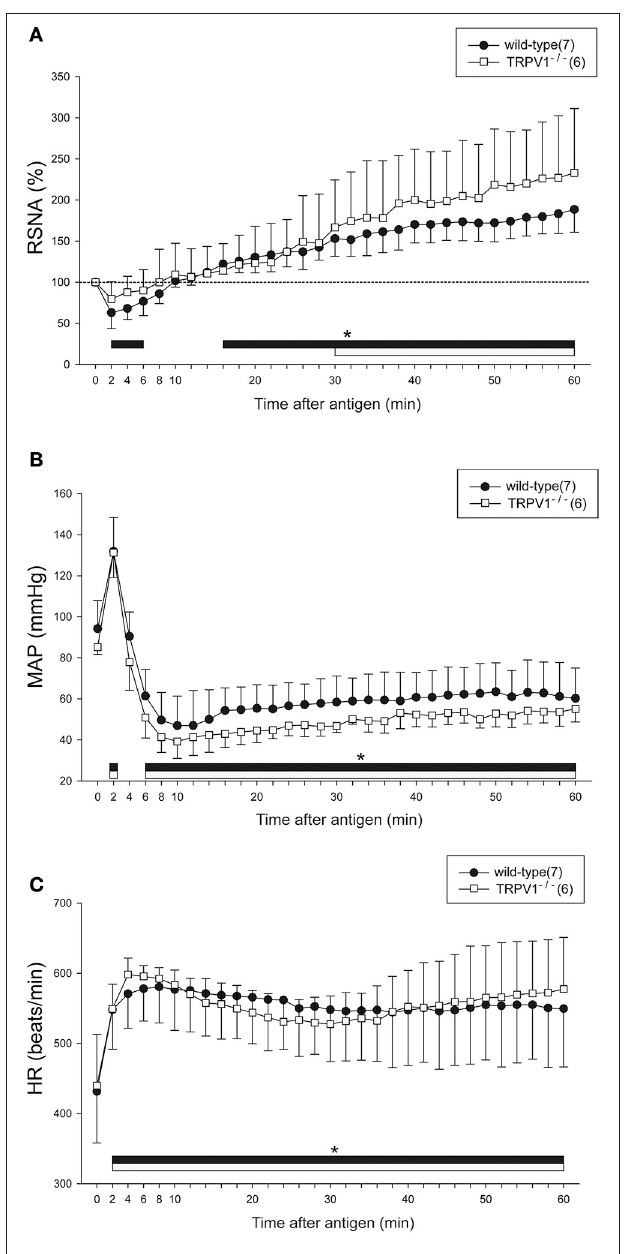
FIGURE 4 | Renal sympathetic and hemodynamic responses to anaphylactic hypotension in TRPV1 − / − mice. Time-course data of the changes in RSNA (A) , MAP (B) , and HR (C) during anaphylactic shock in TRPV1 − / − mice ( (cid:3) ), and wild-type mice ( • ). The numbers of mice used are given in parentheses. Values are expressed as means ± SD. * P < 0.05 vs. the baseline; the black bar and white bar show the significant changes in wild-type mice and TRPV1 − / − mice,